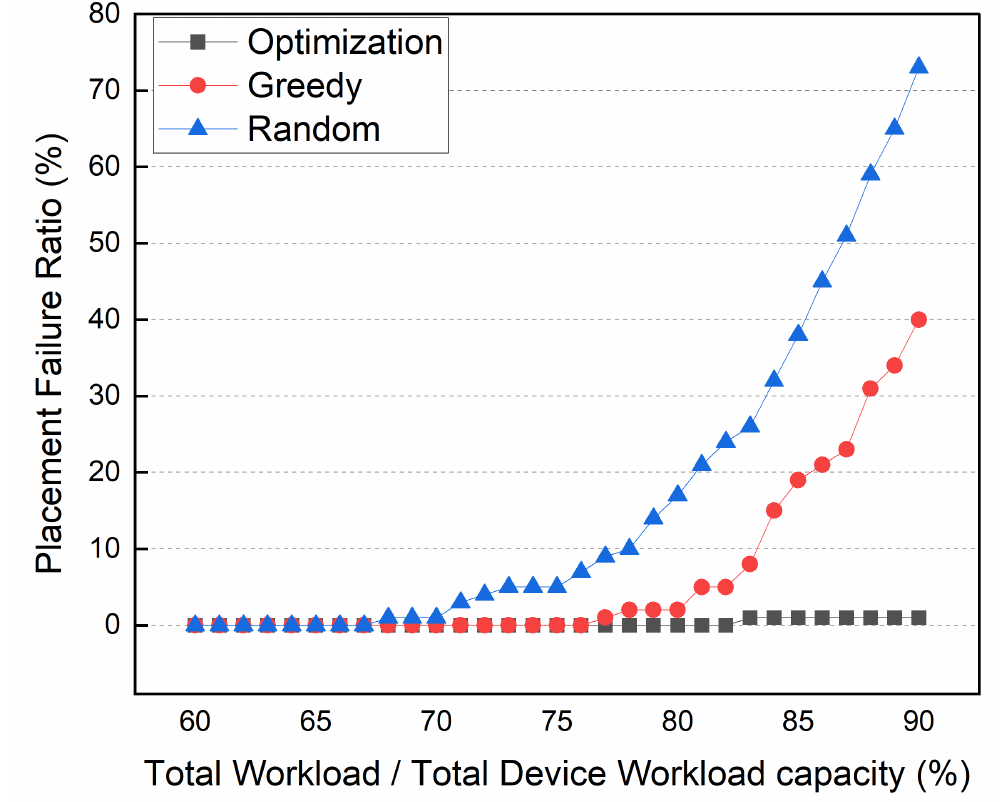
Figure 21. Container Placement Failure